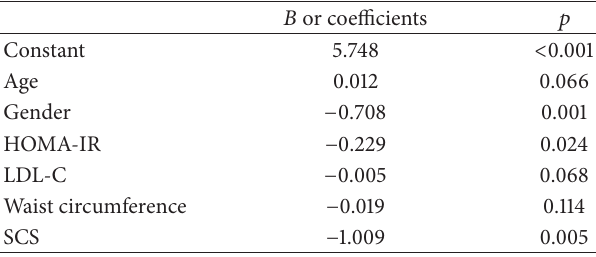
Table 5: Risk factors affecting the adiponectin